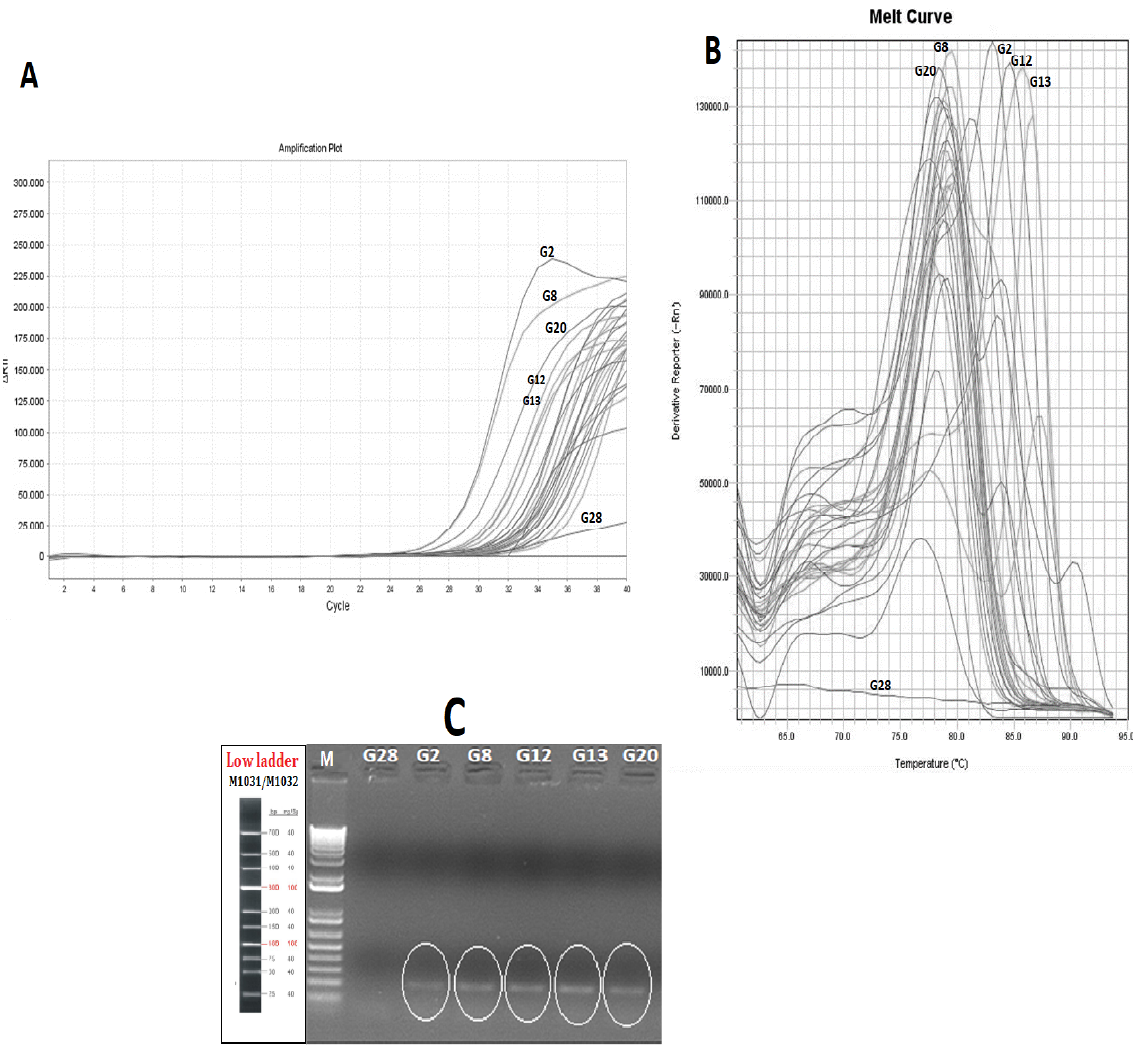
Figure 1. Cycle threshold (Ct) ( A ); Melting curves ( B ) of parvalbumin-encoded gene amplification by RT-PCR ( C ); confirmation of parvalbumin in canned tuna groups on gel electrophoresis (G28: Non-amplified, as negative control, Canned tuna in Sunflower oil; G2: Canned tuna in sunflower oil/tomato sauce; G8: Canned tuna in sunflower oil/canola oil; G12: Canned tuna in sunflower oil; G13: Canned tuna in sunflower oil/spiced; G20: Canned tuna in sunflower oil/tomato sauce). From the 29 analyzed samples, five allergen-positive products were determined (17.2%) and these were varied as the can-filling mediums of the fish allergen-positive groups were: two with tomato-sauce, one that was spiced, one that contained canola oil, and one that contained sunflower oil. Since the tomato, the canola oil, or any of the spices cannot contain parvalbumin proteins, these results can be explained by these ingredients’ impacts on the solubility and structure of them by the process of them binding to the present allergens in the canned tuna. According to previously reported research that was related to impact of complex food matrices on the food-borne allergens. Kenk et al. [36] and Villa et al. [37] reported that lupine was an allergenic food that was detected and impacted by food matrices. Costa et al. [38] also reported on three allergen-encoding genes that were used for the detection of cashew nuts in complex matrices such as wheat, dough, and biscuits. They reported that the detectability of the target genes were im- pacted by food matrices. The specificity of RT-PCR was confirmed by gel electrophoresis.